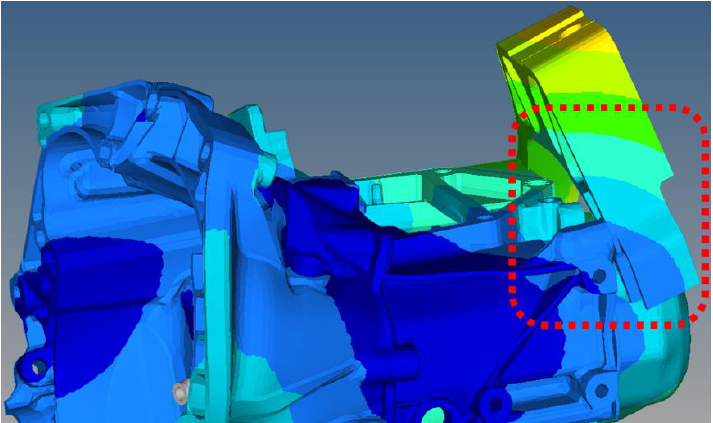
Figure 11. Evidence of the limitations given by the modelling strategy of the contacts, with reference to the relative motion between gear mount and gearbox at 210 Hz.